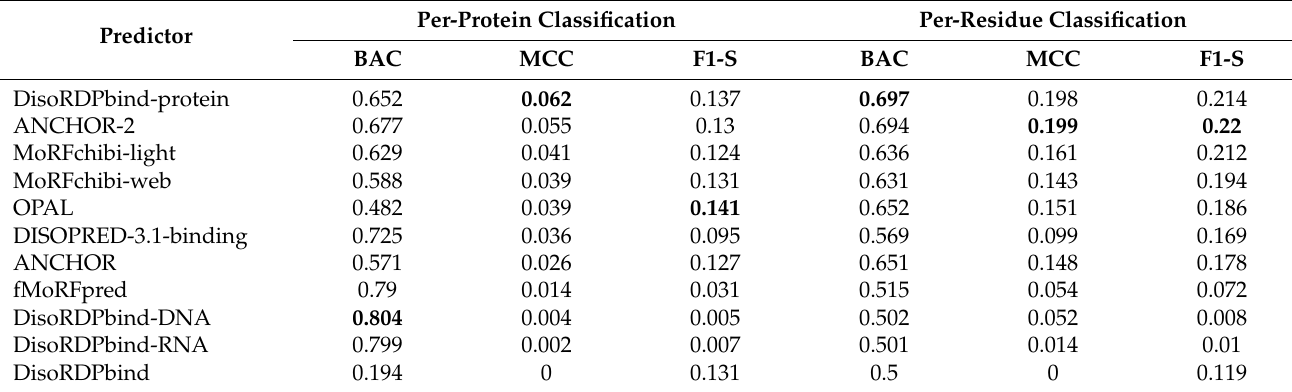
Table 5. The performance of predictors of binding regions in